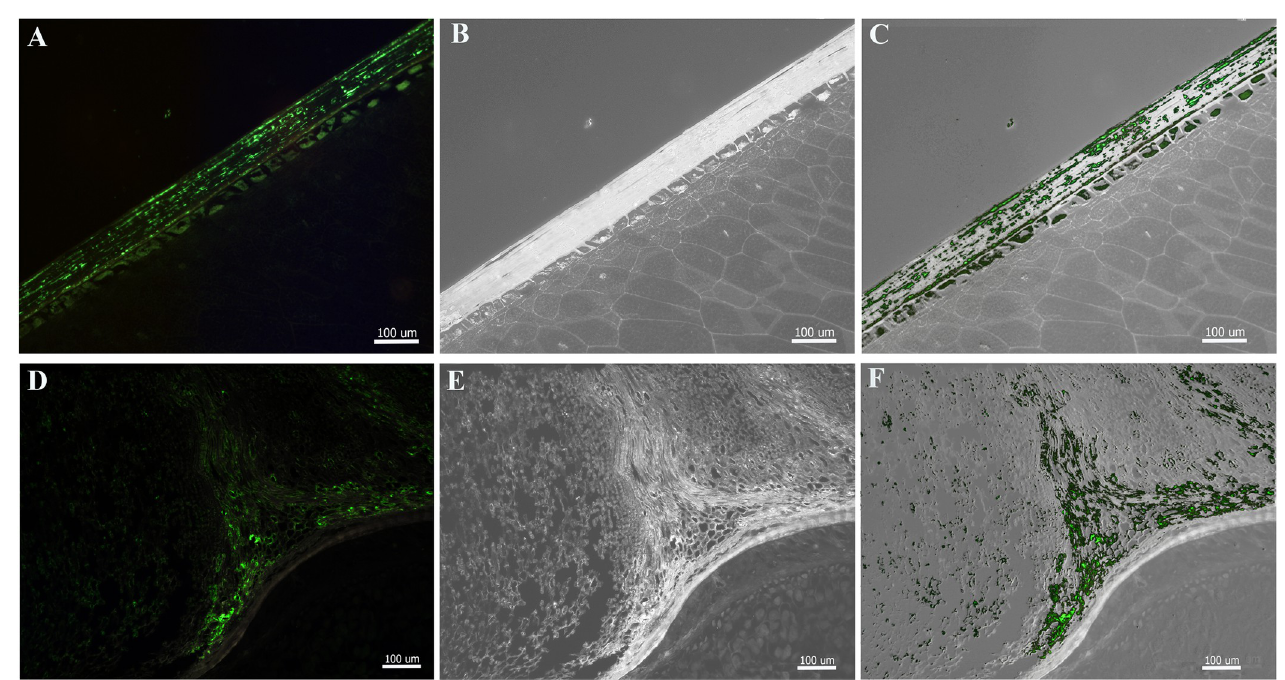
Fig 2. Localization of maize chlorotic mottle virus (MCMV) in seed tissues sections. Representative images of the distribution of MCMV in maize kernel pericarp (A—C) and pedicel (D—F) tissues as determined by fluorescent immunolocalizations using MCMV specific antibody followed by Alexa fluor 488 secondary antibody (green).